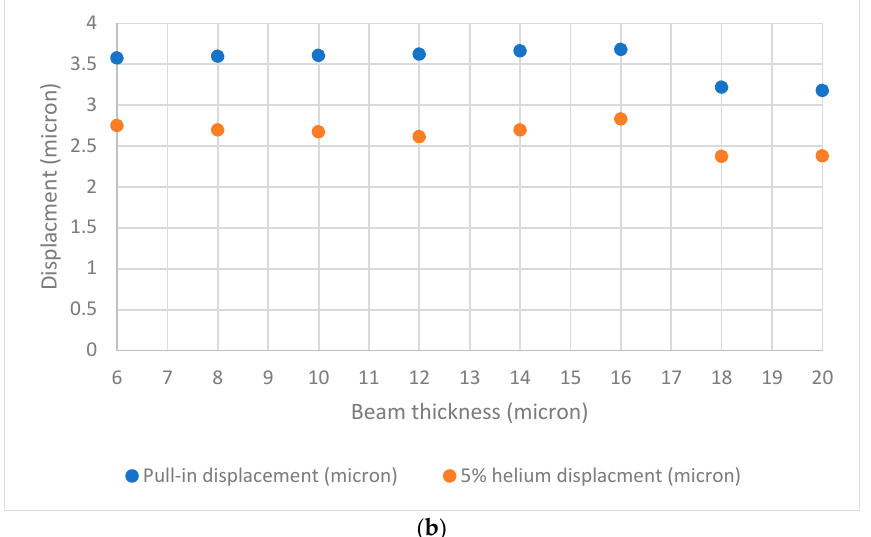
Figure 13. ( a ) Effect of thickness on the input voltage amplitude to the sensor at the same electrical parameters. ( b ) Displacement at 0 and 5% helium levels based on the thickness of the beam.